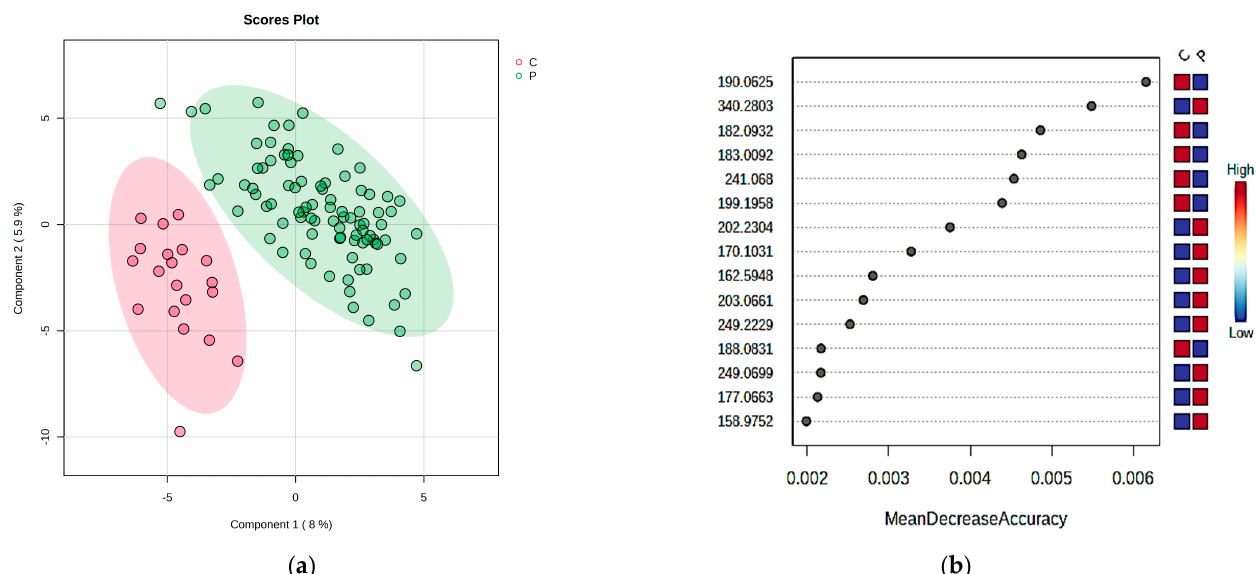
Figure 1. Multivariate analysis of serum samples: ( a ) PLSDA score and plot for serum samples; ( b ) MDA scores according to Random Forest analysis.